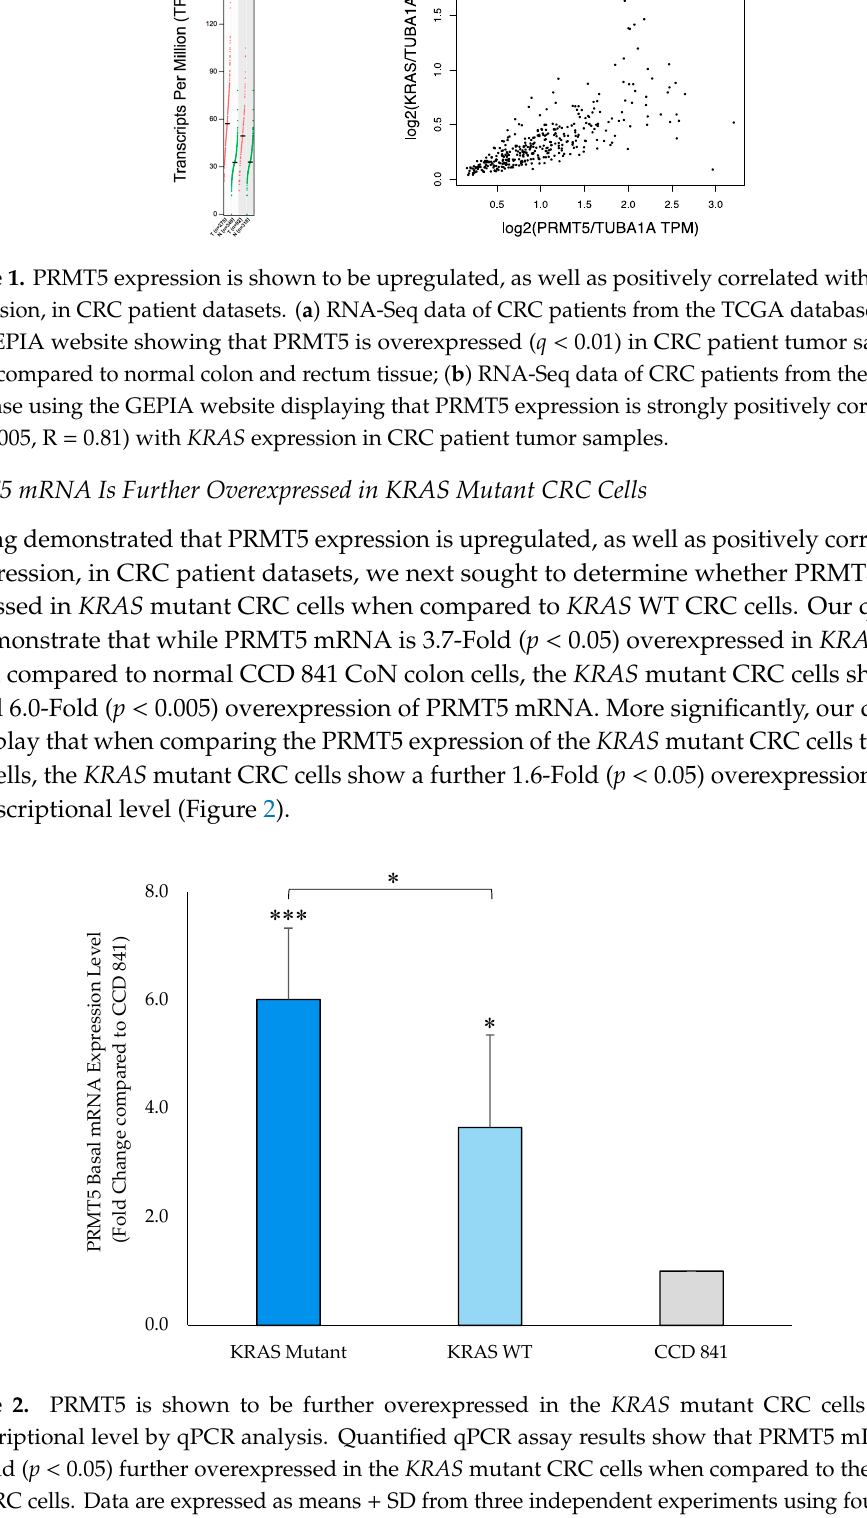
Figure 2. PRMT5 is shown to be further overexpressed in the KRAS mutant CRC cells at the transcriptional level by qPCR analysis. Quantified qPCR assay results show that PRMT5 mRNA is 1.6-Fold ( p < 0.05) further overexpressed in the KRAS mutant CRC cells when compared to the KRAS WT CRC cells. Data are expressed as means + SD from three independent experiments using four CRC cell lines (2 KRAS mutant, 2 KRAS WT), as well as one normal colon cell line. Data for the individual cell lines can be seen in Figures S2 and S3. * represents p < 0.05; *** represents p <